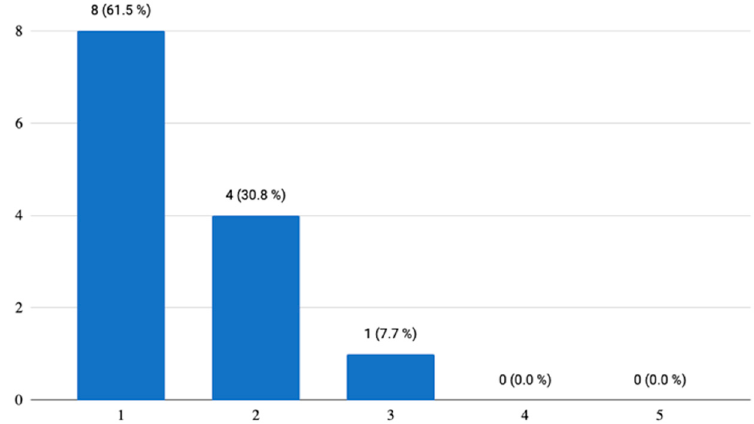
Figure 6. Use of the application during the U3V English courses.